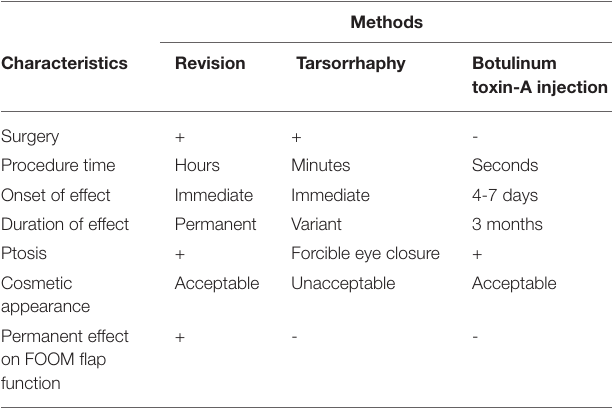
TABLE 1 | Comparison among different treatments for refractory exposure keratopathy after FOOM flap shortening.